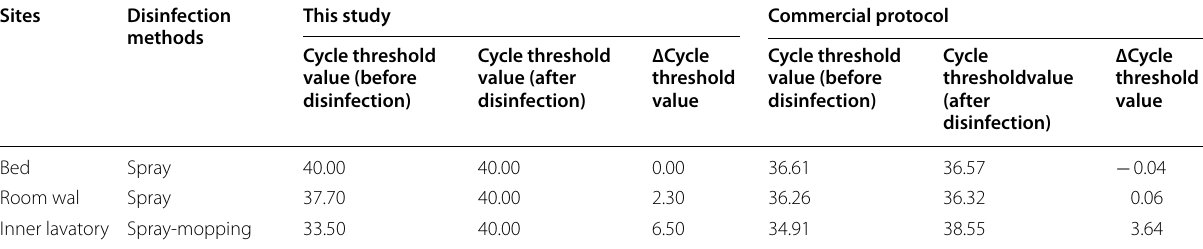
Samples were collected from test surfaces before and after disinfection